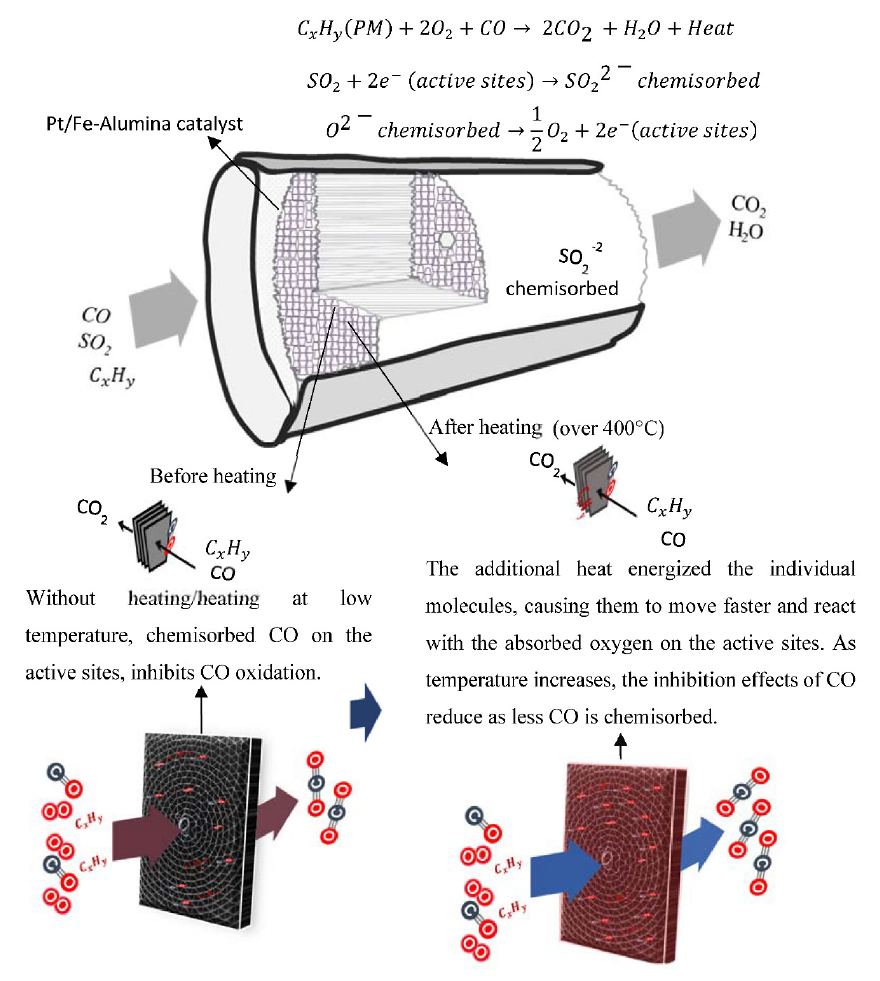
Figure 5. Illustration of the metallic honeycomb catalyst flue oxidative decomposition reaction. Note: For illustration, PM in this study is referred to as C x H y